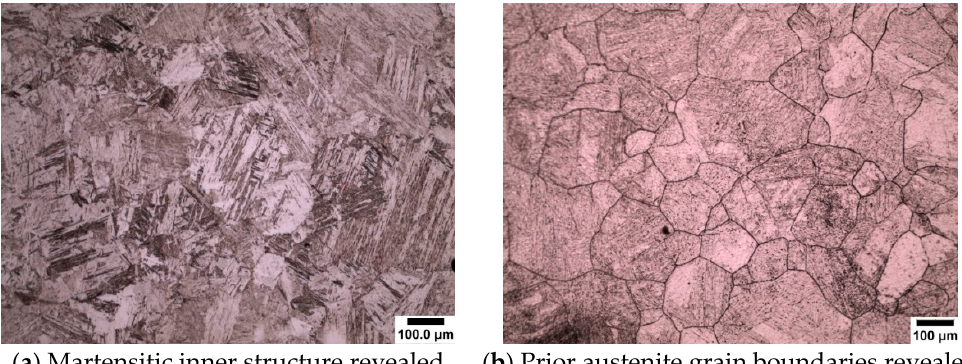
( a ) Martensitic inner structure revealed ( b ) Prior austenite grain boundaries revealed Figure 12. Illustrates the effect of the wetting agent on low carbon (0.08 wt.%) steel with 0.02 wt.% Nb (1150 ℃ ). Teepol was used as the wetting agent in ( a ) and SDS used as the wetting agent in ( b